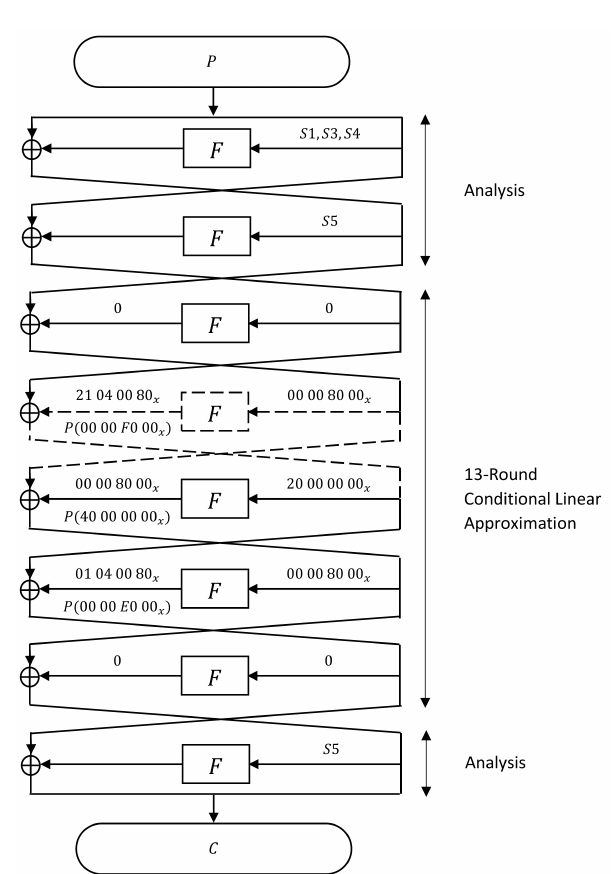
Figure 13: Outline of the 16-Round Attack (Using λ 4